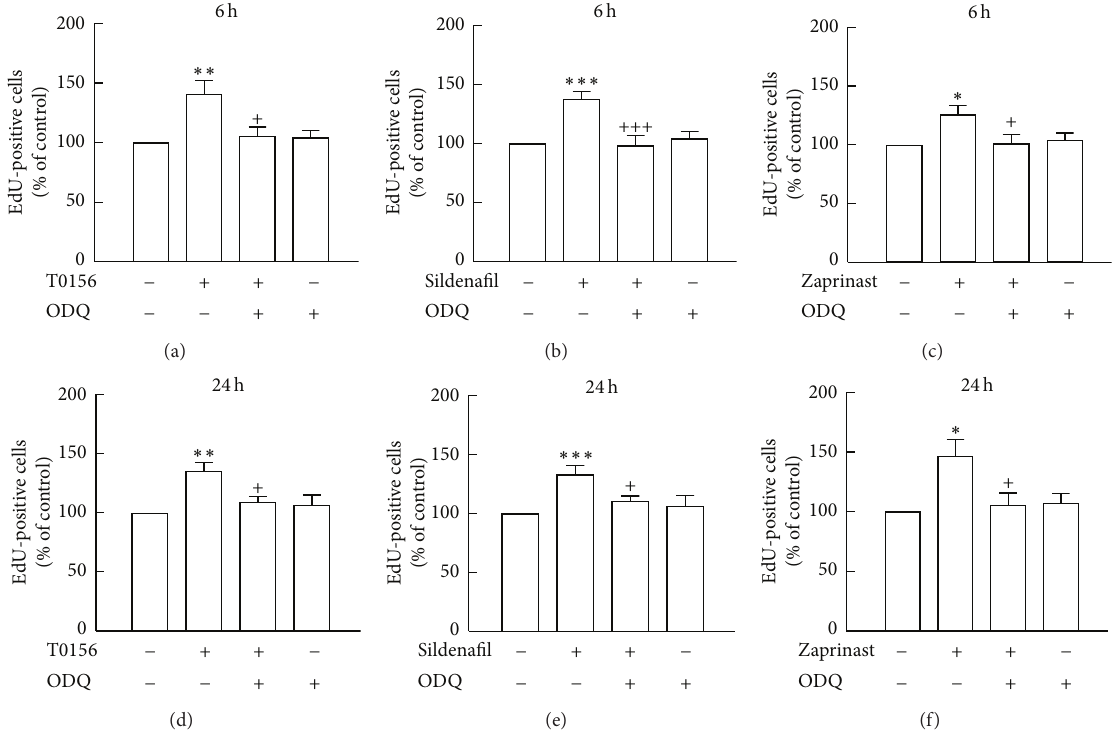
Figure 4: Inhibition of sGC prevented the proliferation of SVZ cells stimulated by PDE5 inhibitors. Cell proliferation following treatment with 50 𝜇 M ODQ and 1 𝜇 M T0156 (a, d), 1 𝜇 M sildenafil (b, e), or 10 𝜇 M zaprinast (c, f) was assessed by incorporation of EdU and evaluated by flow cytometry, following 6 h or 24 h treatment. Data are expressed as means ± SEM of at least 5 independent experiments. One-way ANOVA (Bonferroni’s post-test), ∗ 𝑃 < 0.05 , ∗∗ 𝑃 < 0.01 and ∗∗∗ 𝑃 < 0.001 , significantly different from control and + 𝑃 < 0.05 and +++ 𝑃 < 0.001 significantly different from the PDE5